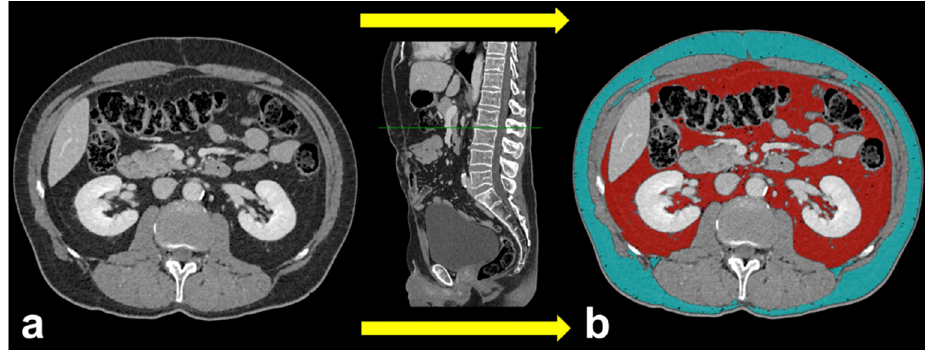
Figure 2. Axial CT images showing a single slice located 3 cm above the lower margin of L3 without ROIs ( a ) and the same slice with superimposed colored ROIs of VAT area (red ROI) and of SAT area (cyan ROI) ( b ). The sagittal plane, depicted in the middle, has been used as a reference to drive the correct ROI drawing for each subject.